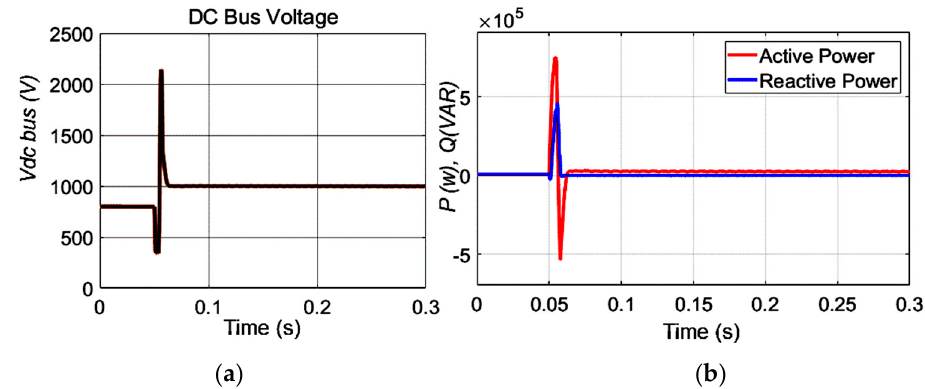
Figure 12. ( a ) DC bus voltage. ( b ) Active and reactive power.